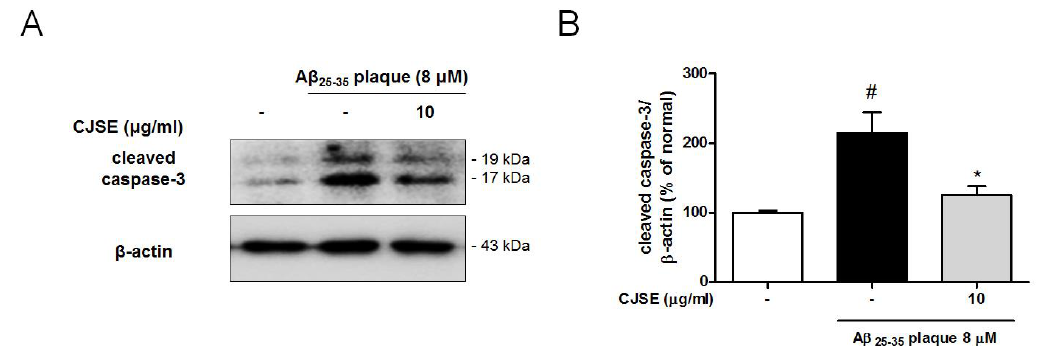
Figure 4. Effects of CJSE on expression of activated caspase-3 in mouse primary neuronal culture. ( A ) Representative band images of cleaved caspase-3 expression. ( B ) Quantifications of cleaved caspase-3 levels were normalized to β -actin. Values are indicated as the mean ± S.E.M. # p < 0.05 compared to the normal group; * p < 0.05 compared to Aβ-treated group.